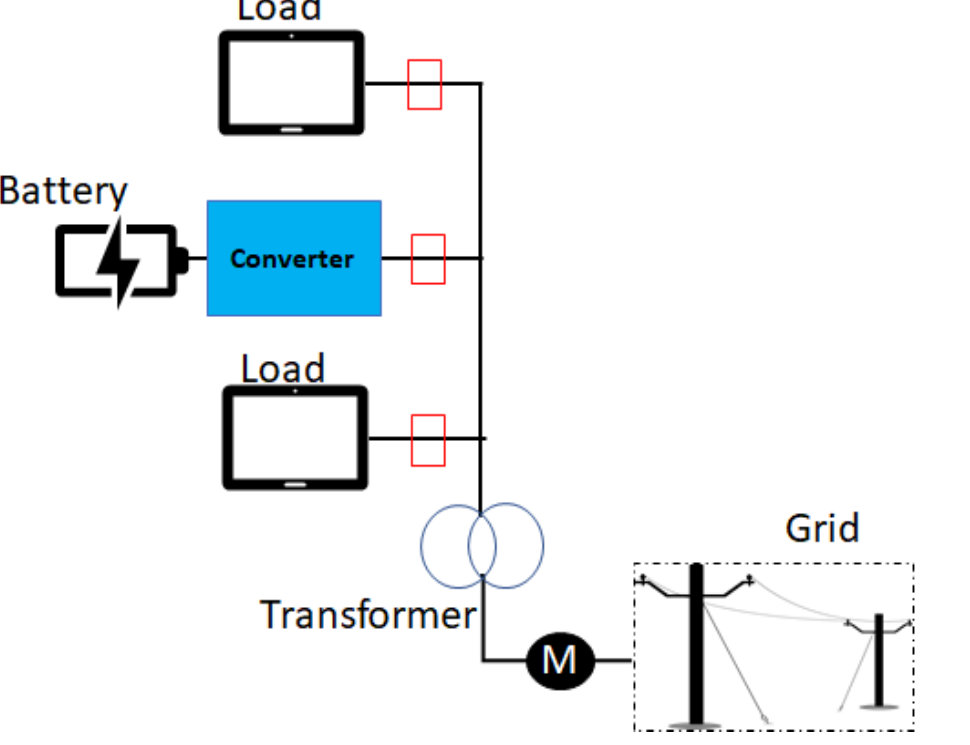
Table 1. Assumptions for the base case.